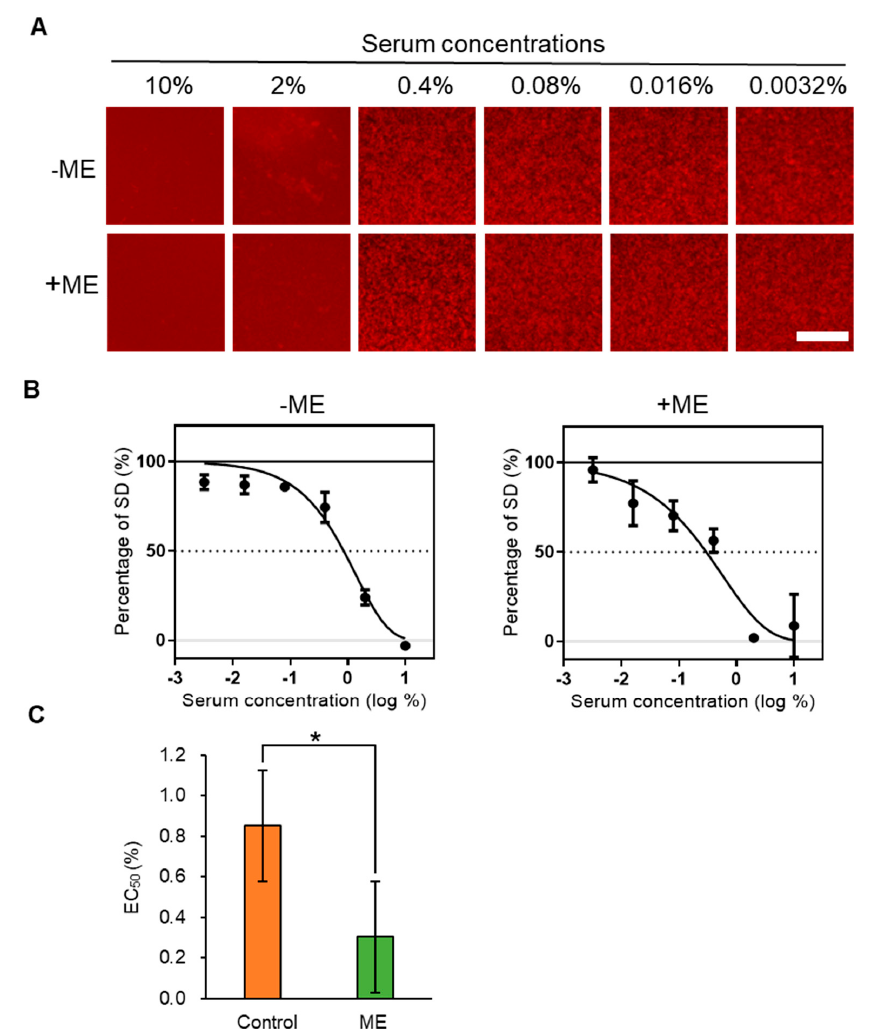
Figure 2. Estimation of EC 50 of serum for mSAA aggregation by the MSHTS system. ( A ) mSAA containing QD nanoprobes were incubated with various concentrations of + ME or − ME group sera. ( B ) Estimation of EC 50 values from inhibition curves. ( C ) Comparison of the EC 50 values of + ME and − ME groups (* p < 0.05, Welch’s t -test) ( n = 3 separate experiments). Each plot and bar graphs represents mean ±